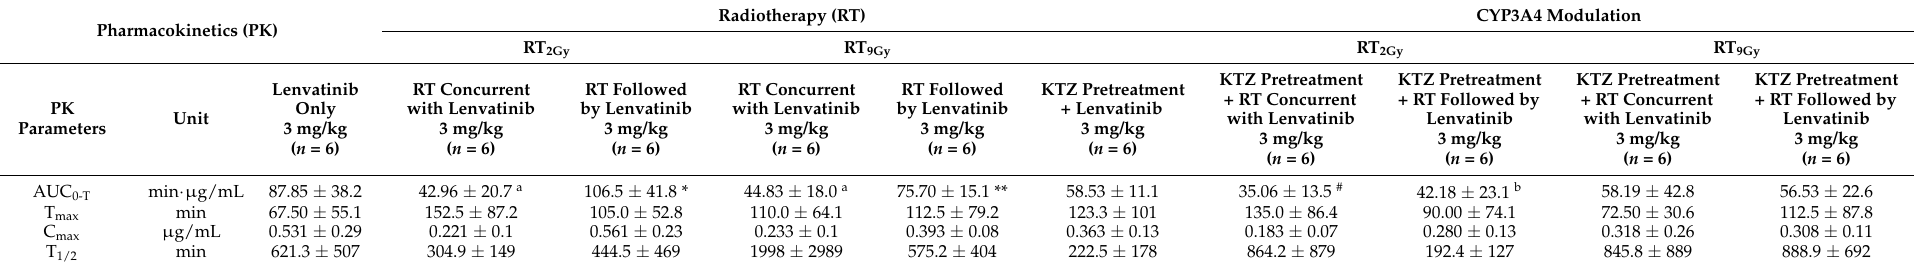
Table 1. Pharmacokinetic parameters of lenvatinib in rats after administration for 3 d (3 mg/kg, p.o.) with or without radiotherapy (RT, 2 Gy and 9 Gy) and ketoconazole (KTZ, 10 mg/kg, i.p., 30 min, before RT or lenvatinib).